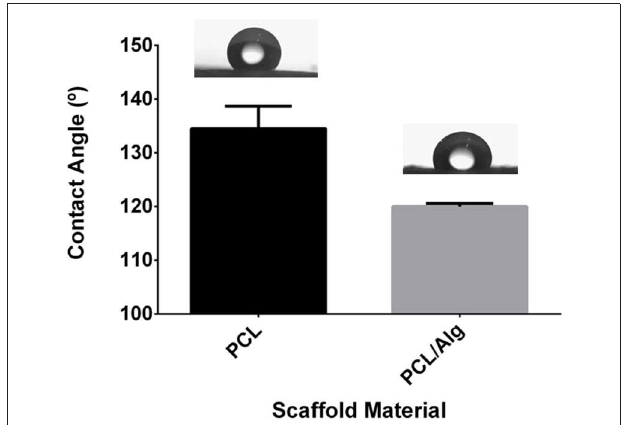
FIGURE 6 | Cell proliferation on PCL and PCL/Alginate ESP Scaffolds. (A) Metabolic activity of the cells on PCL and PCL/alginate meshes over 14 days of culture measured by presto blue assay. (B) Cell number after 14 days of culture. Data are represented as mean ± standard deviation ( N = 5; There is no significant difference).